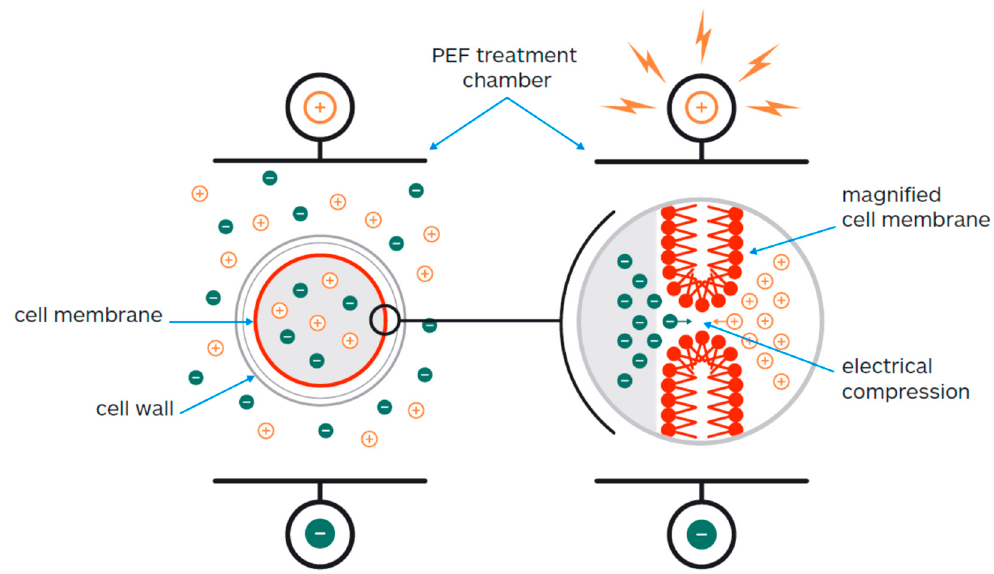
Figure 2. Schematic diagram describing the phenomenon of electroporation in biological tissue using PEF.